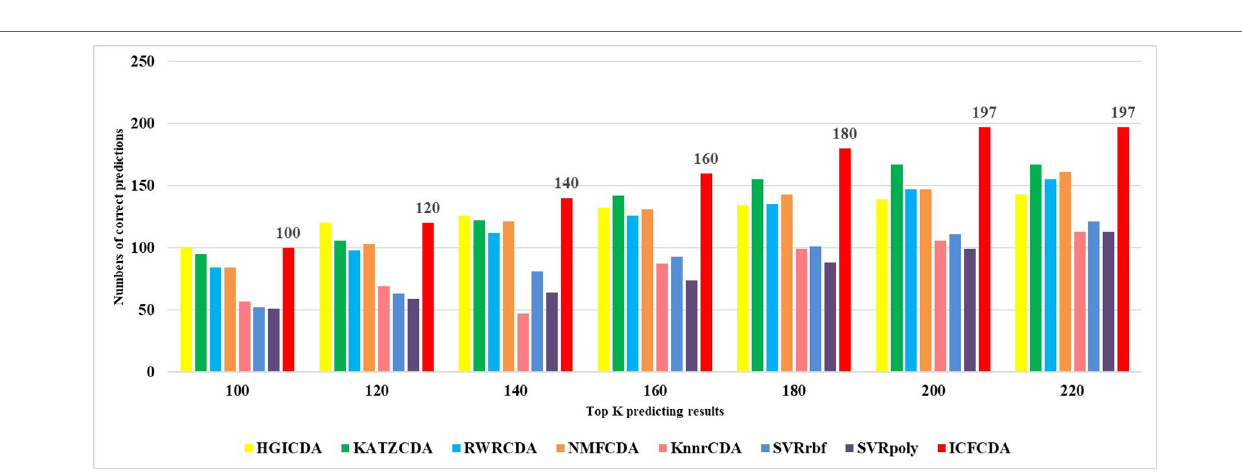
FIGURE 6 | The number of correct circRNA–disease association in top k predicting results.